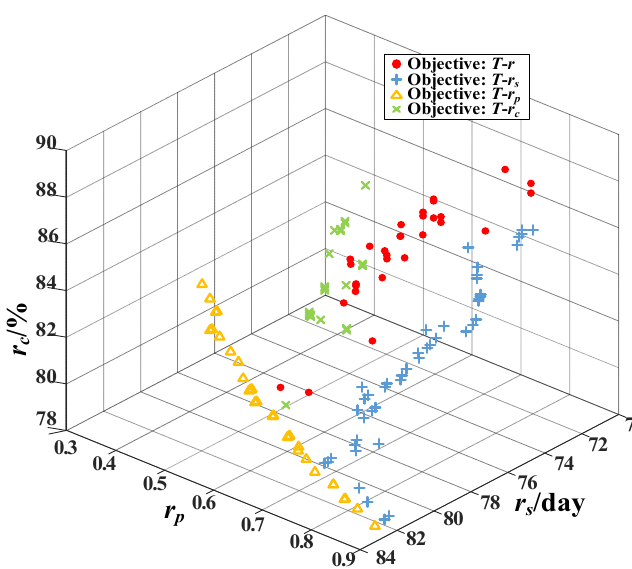
Figure 10. The optimized schedules with the objectives of T - r , T - r s , T - r p , and T - r c .